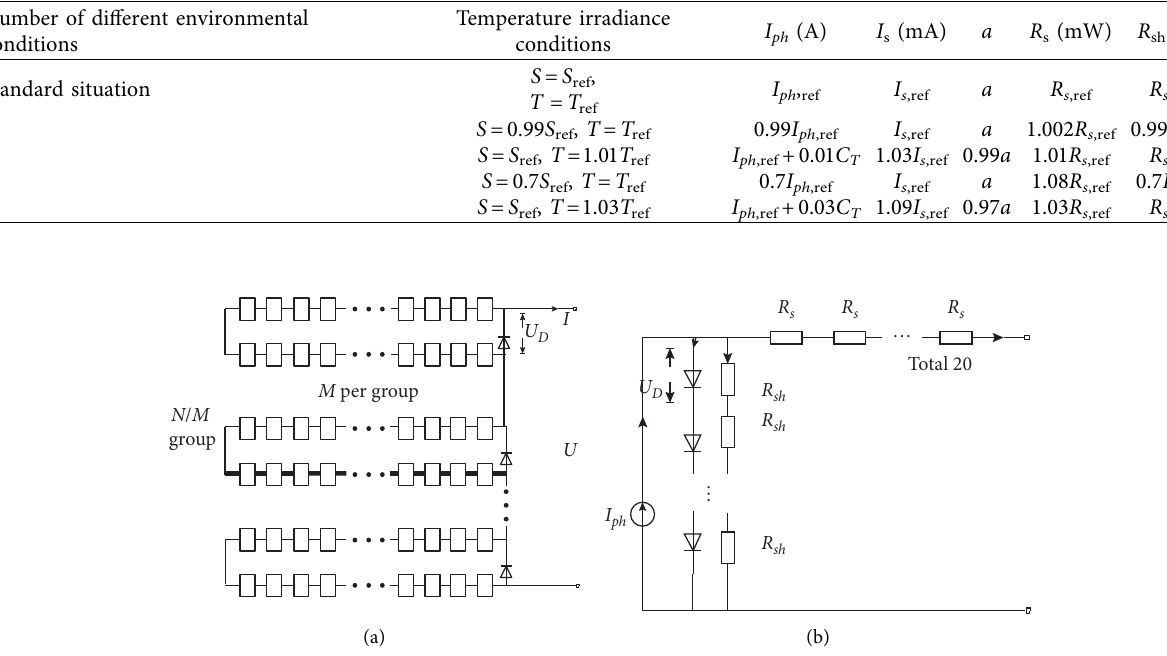
Table 1: Relationship between the parameters and conditions.